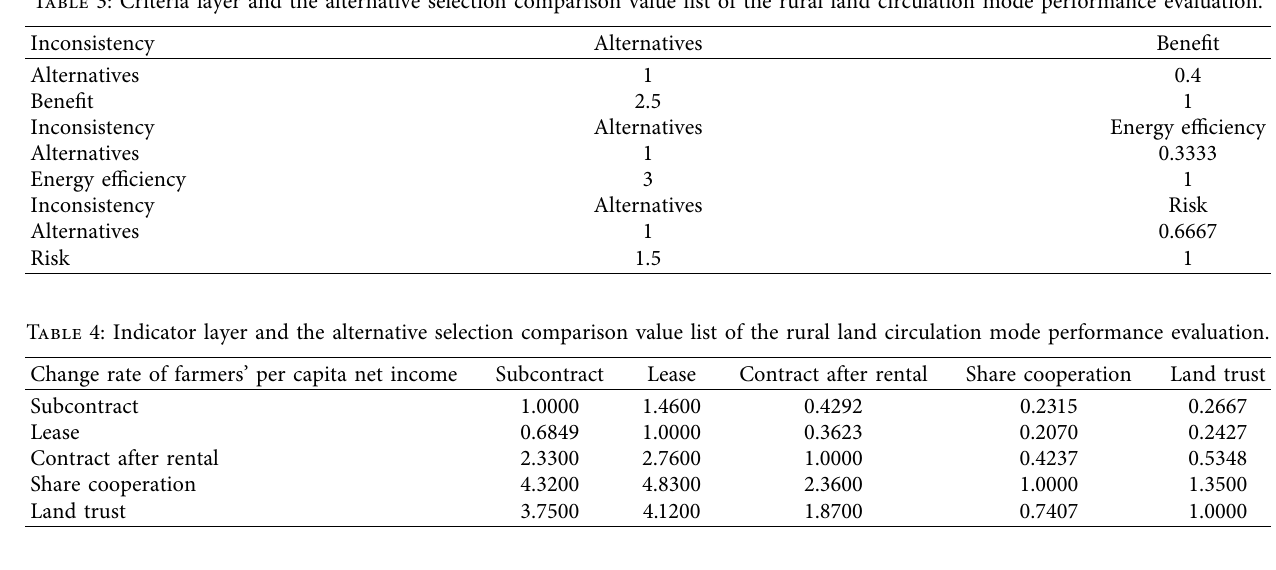
Table 5: Cluster weight results of the rural land circulation mode performance evaluation.